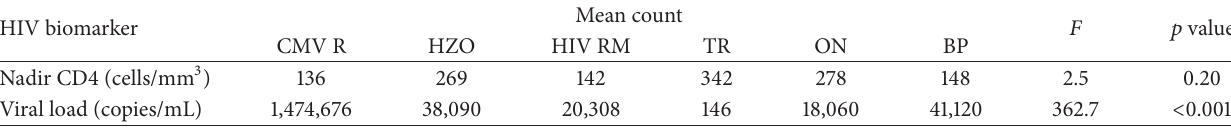
Table 3: Comparing mean CD4 counts/viral loads between patients who manifested ocular disorders and those who did not. Mean count (CI) 𝑡 𝑝 HIV biomarker Participants with ocular disorders Participants without ocular disorders Nadir CD4 count (cells/mm 3 ) Current CD4 count (cells/mm 3